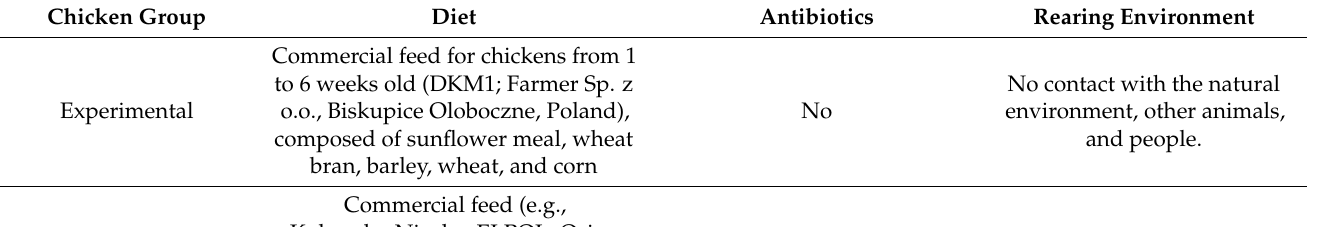
Table 2. The selected rearing